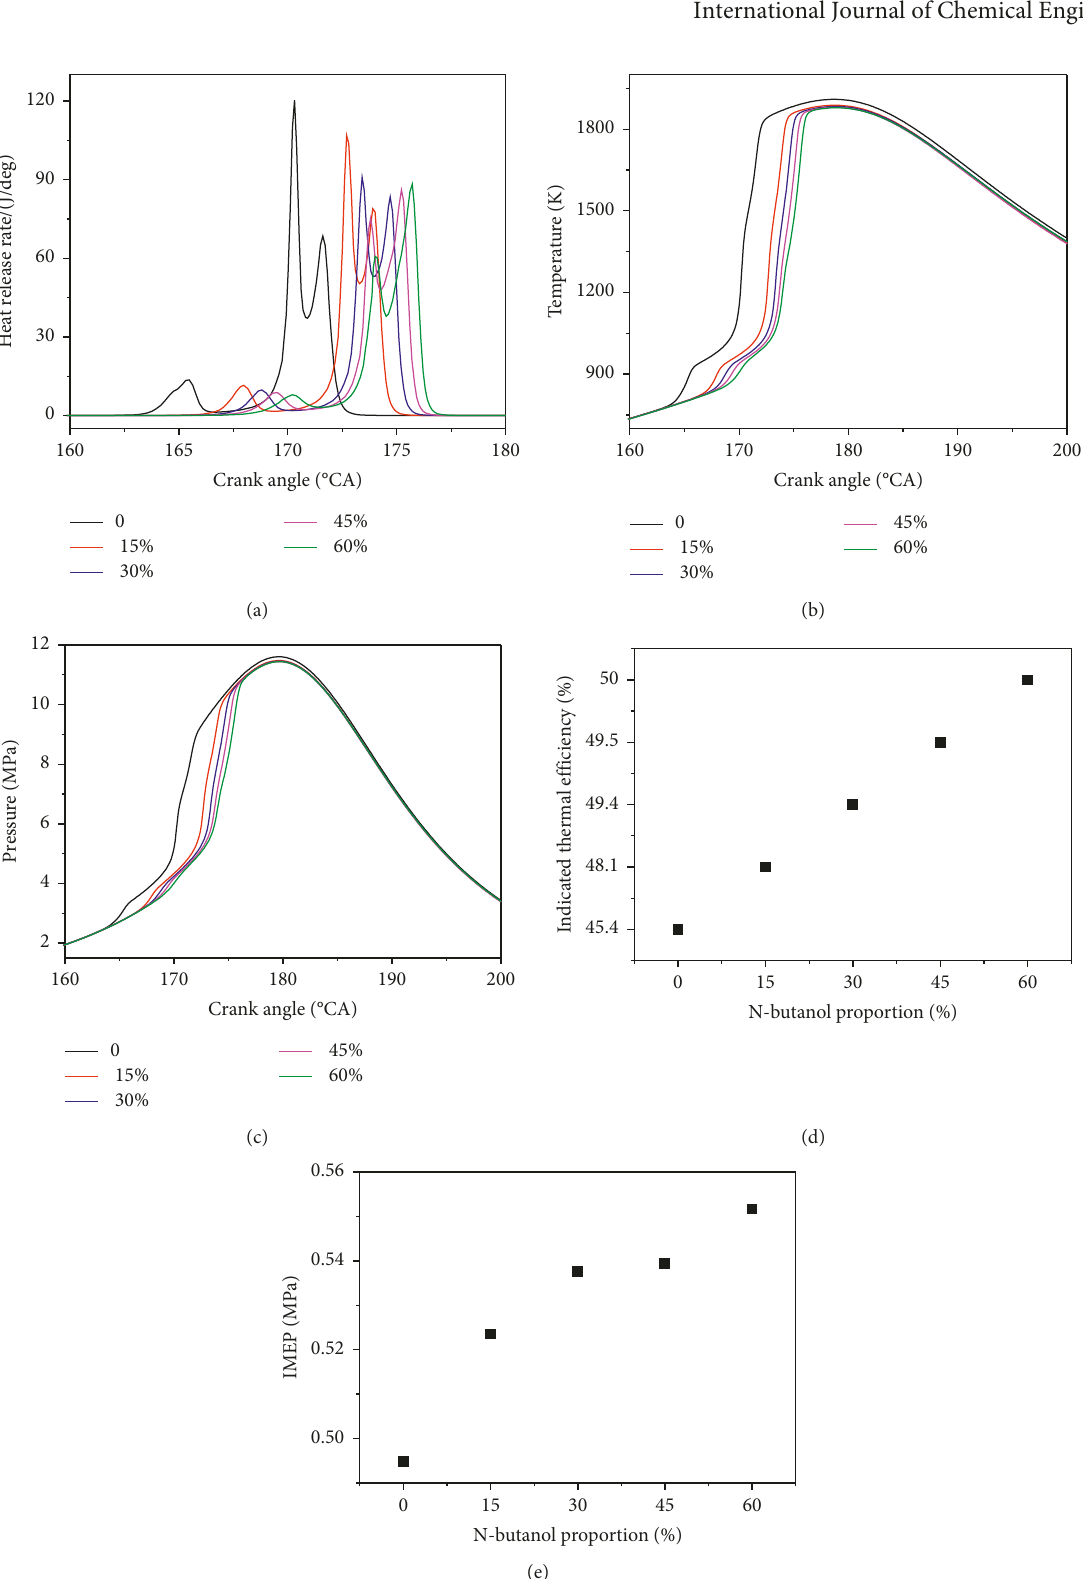
Figure 5: The combustion performance of different n -butanol